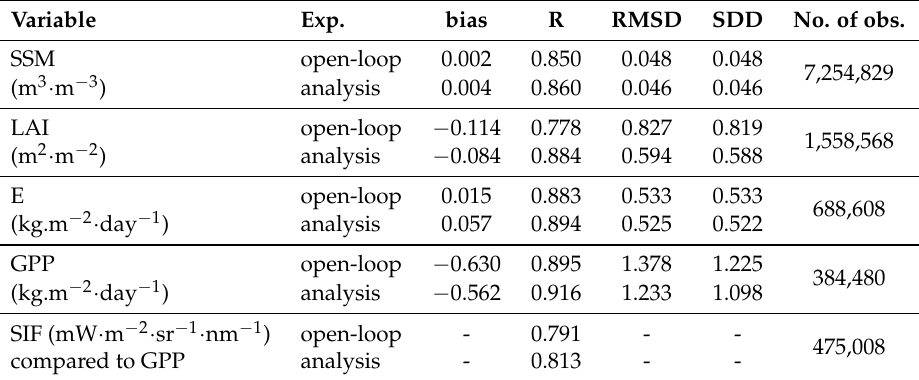
Table 1. Statistics between the simulations (open-loop and analysis) and the observations for CGLS SSM, CGLS LAI, GLEAM Evapotranspiration (E), FLUXNET-MTE GPP and between observed GOME-2 SIF and simulated GPP over the Euro-Mediterranean area from 2007–2015: bias, correlation (R), Root-Mean-Square Difference (RMSD), Standard Deviation of Differences (SDD) and the number of